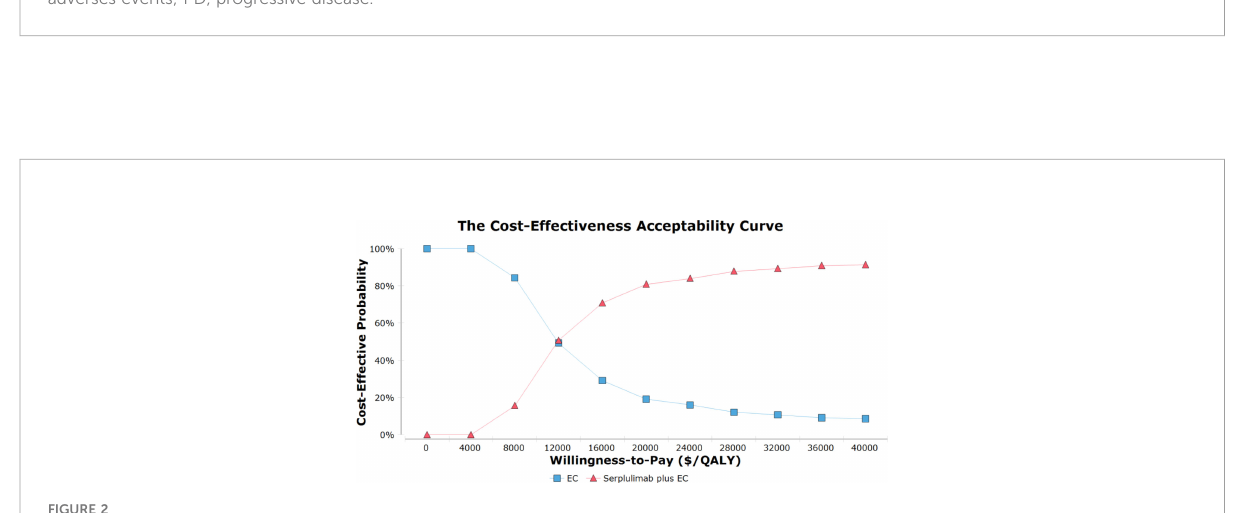
FIGURE 2 The cost-effectiveness acceptability curves for serplulimab plus chemotherapy group compared to chemotherapy group. EC, etoposide and carboplatin; QALY, quality-adjusted